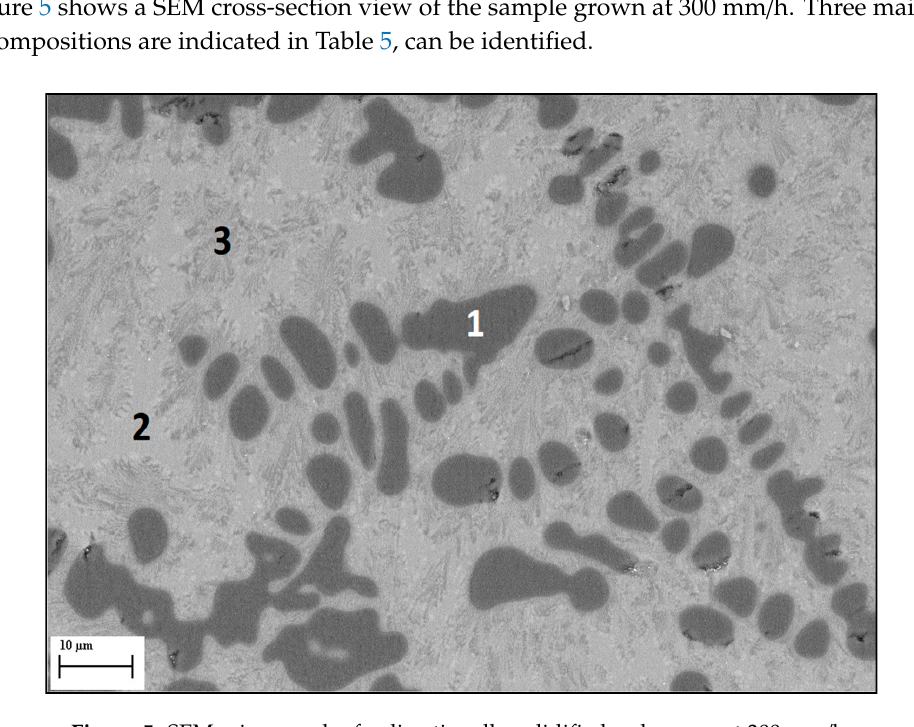
Figure 5. SEM micrograph of a directionally solidified rod grown at 300 mm/h.